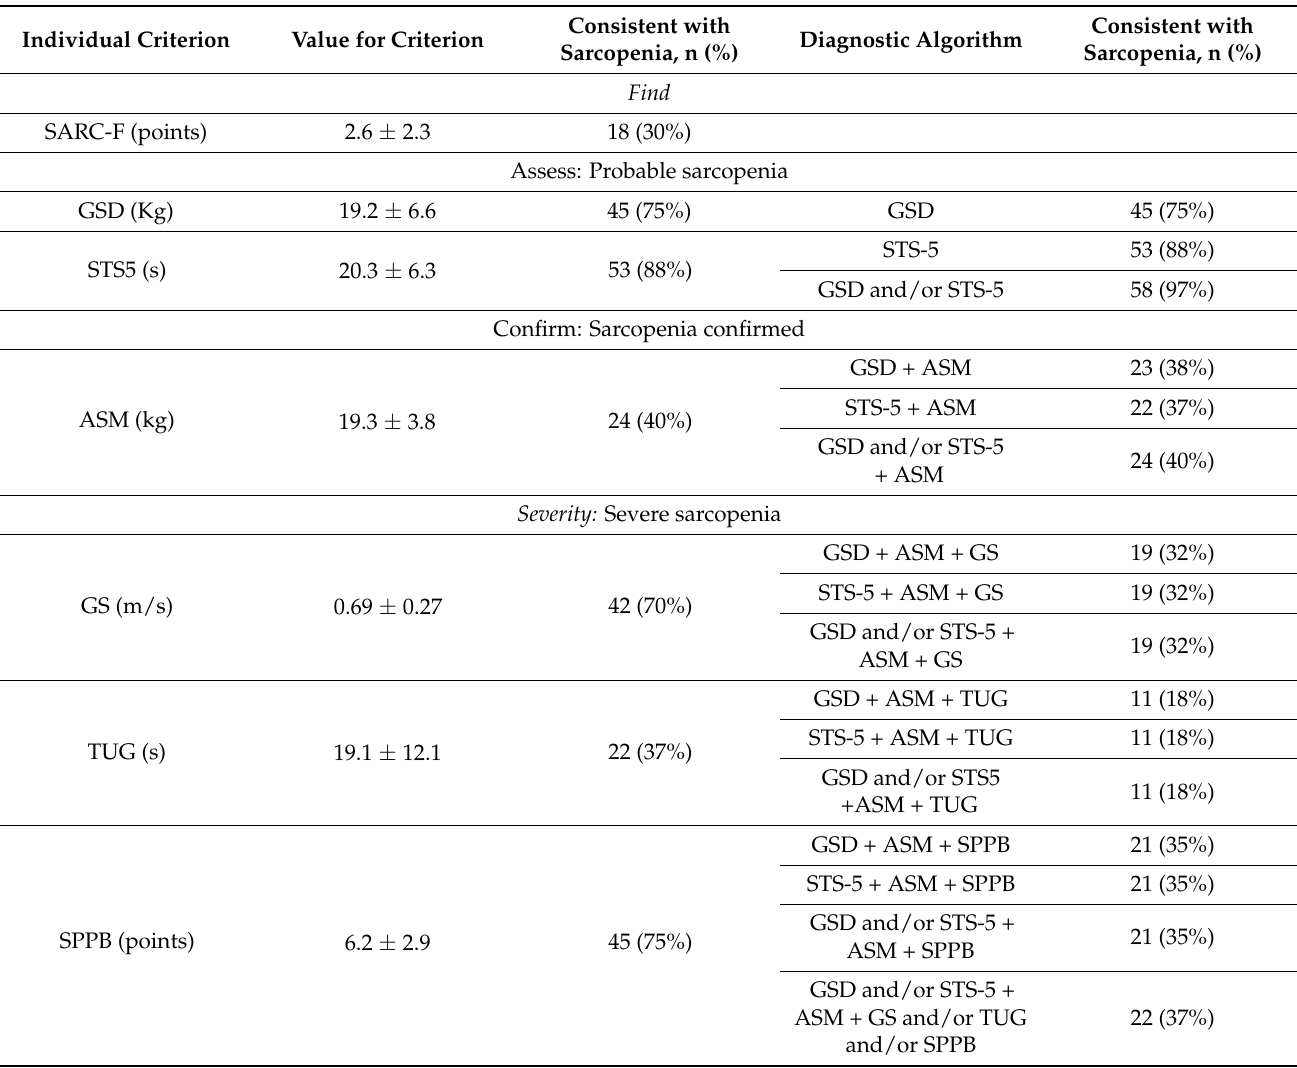
Table 3. The mean values of the sarcopenia marker variables, the frequency of sarcopenic individuals for each variable and the prevalence of sarcopenia according to the EWGSOP2 diagnostic algorithm. n = 60. Data presented as mean ± SD or n